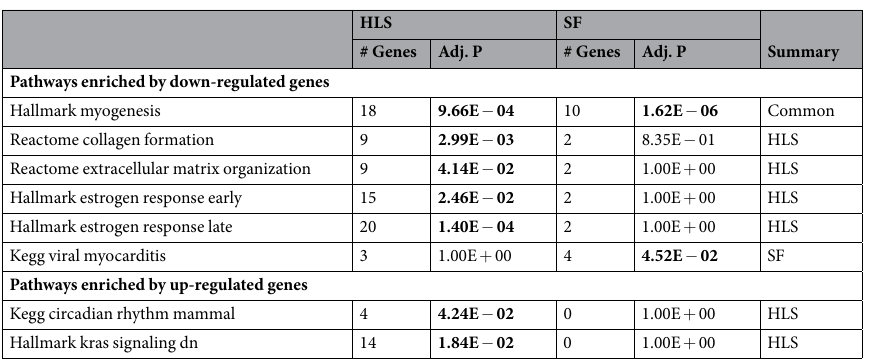
HLS SF Summary# Genes Adj. P # Genes Adj. P